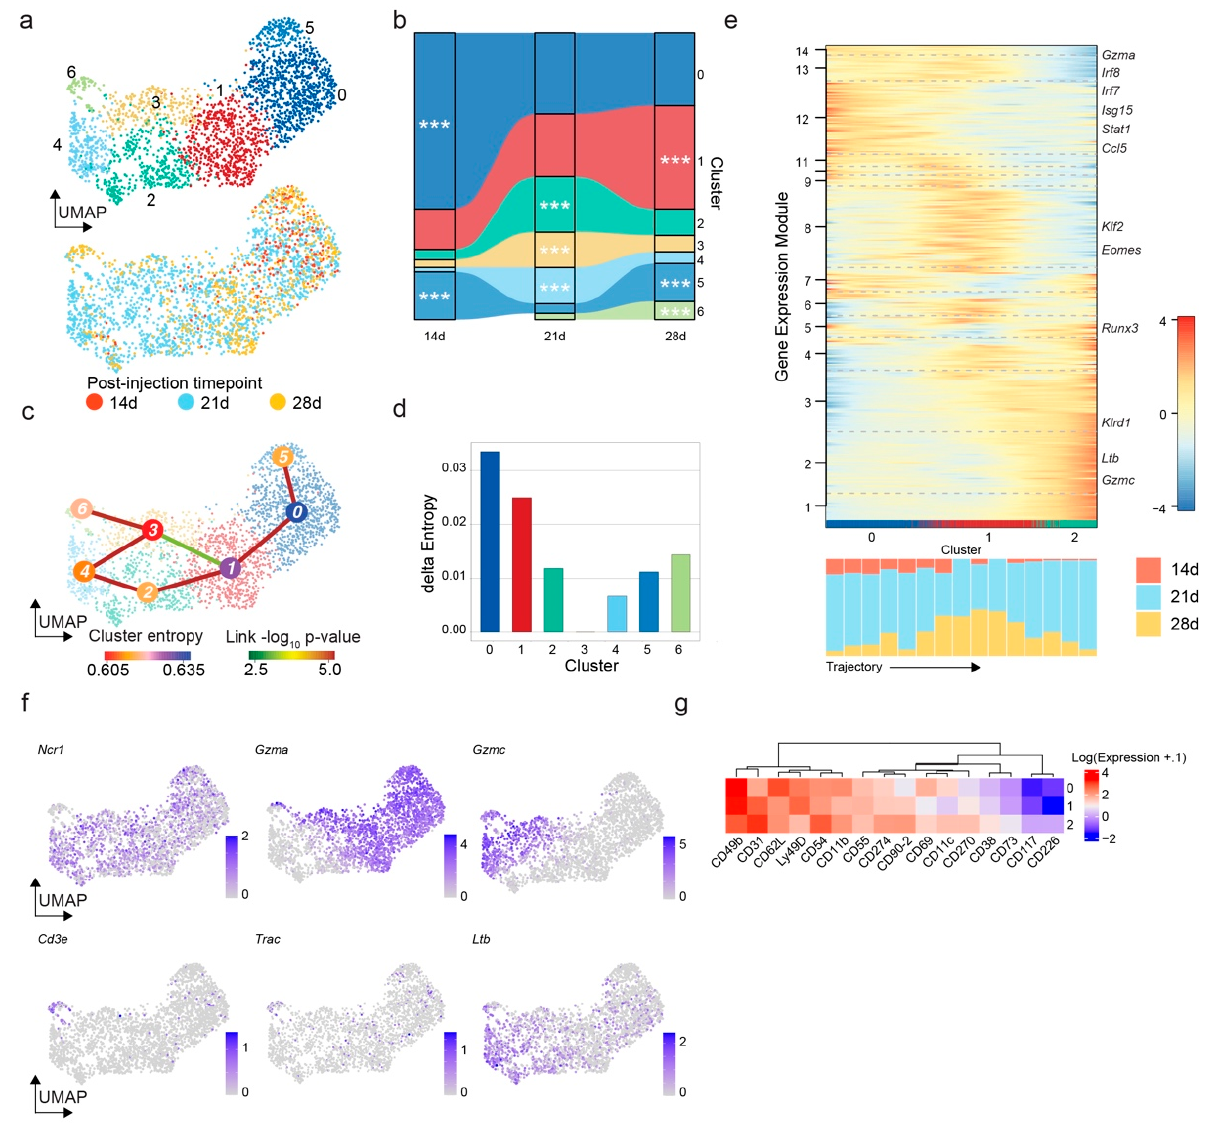
Figure 3. Characterization of NK cells during GL261 murine orthotopic glioma progression. ( a ) UMAP visualization of 2664 cells sub-clustered from the NK cell cluster of Figure 1c. The color coding of the top panel corresponds to the new cluster assignment. The bottom panel is color-coded by the p.i. time point. ( b ) Alluvial plot indicating the cluster distribution of the indicated p.i. time point. ( c ) UMAP visualization of the data from figure panel a superimposed by the lineage graph determined using the StemID algorithm. The nodes are color-coded by the transcriptional entropy of the indicated clusters; the link color indicates the p -value of the indicated connection. ( d ) Bar plot showing the transcriptional entropy differences across the cluster. Cluster 3 with the lowest entropy is set to 0. The color coding is consistent with the top part of figure panel a. ( e ) Heatmap of the locally smoothed gene expression z-scores along the trajectory between Clusters 0, 1 and 2. Genes with a correlation coefficient above 9 are summarized into gene expression modules; gene expression modules with at least 3 genes are shown. The bar plot below the heatmap indicates the time point composition of each step along the trajectory. ( f ) UMAP visualization of cells from figure panel a color-coded by the expression of the indicated genes. ( g ) Heatmap showing the log-transformed expression of the differentially expressed proteins in the indicated